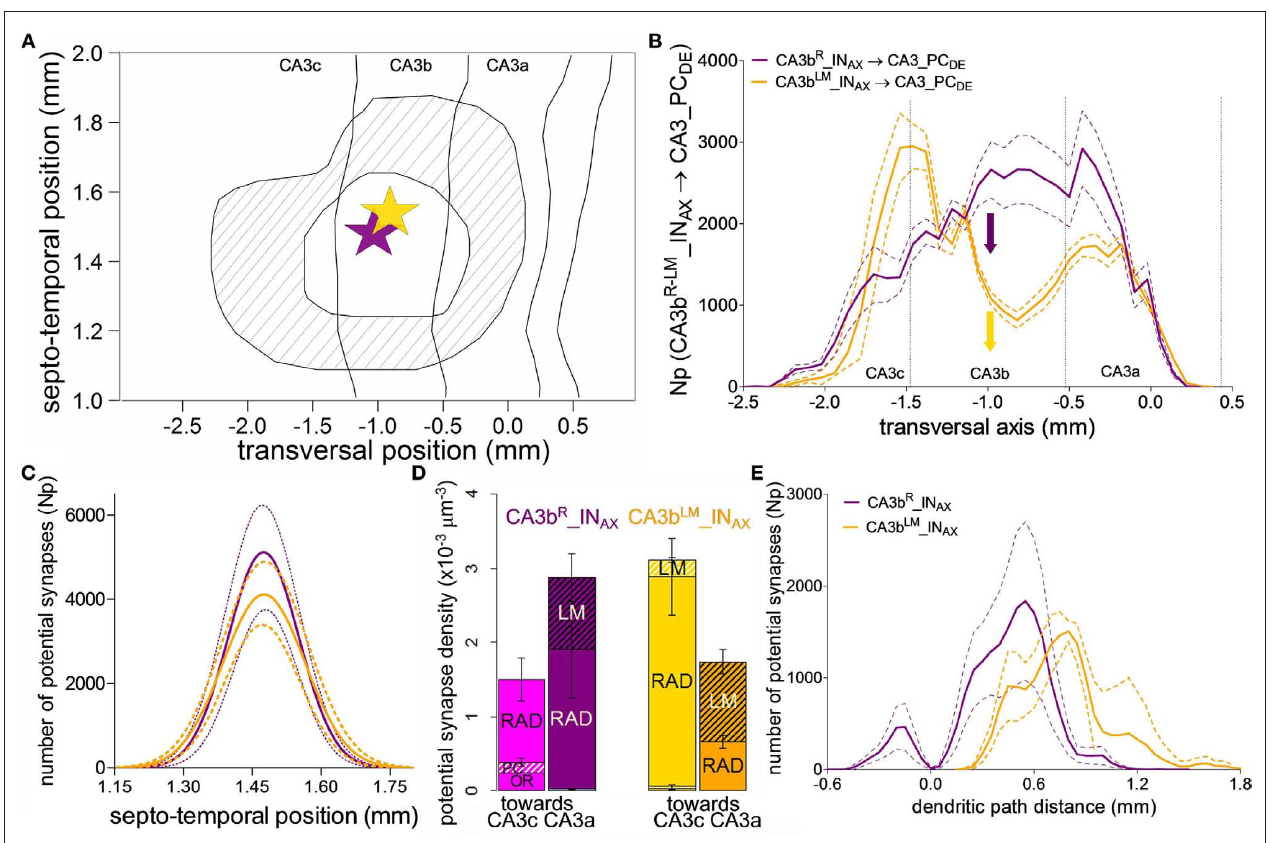
LM neurons. (B) Mean potential synapse distributions and 95% confidence intervals for six CA3b R _IN (purple) and seven CA3b LM _IN (gold) along the AX AX transversal axis. The solid colored arrows indicate the average transversal positions of the somata. The vertical dashed lines demarcate the boundaries between the three CA3 sub-regions. (C) Gaussian fits of the means and 95% confidence intervals for the septo-temporal distributions of potential synapses. (D) Transversal patterns (“toward CA3c” vs. “toward CA3a”) and layer specificity in potential synapse densities for the two CA3b interneuron types. (e) Potential synapse distribution along the dendritic path distance of CA3 pyramidal